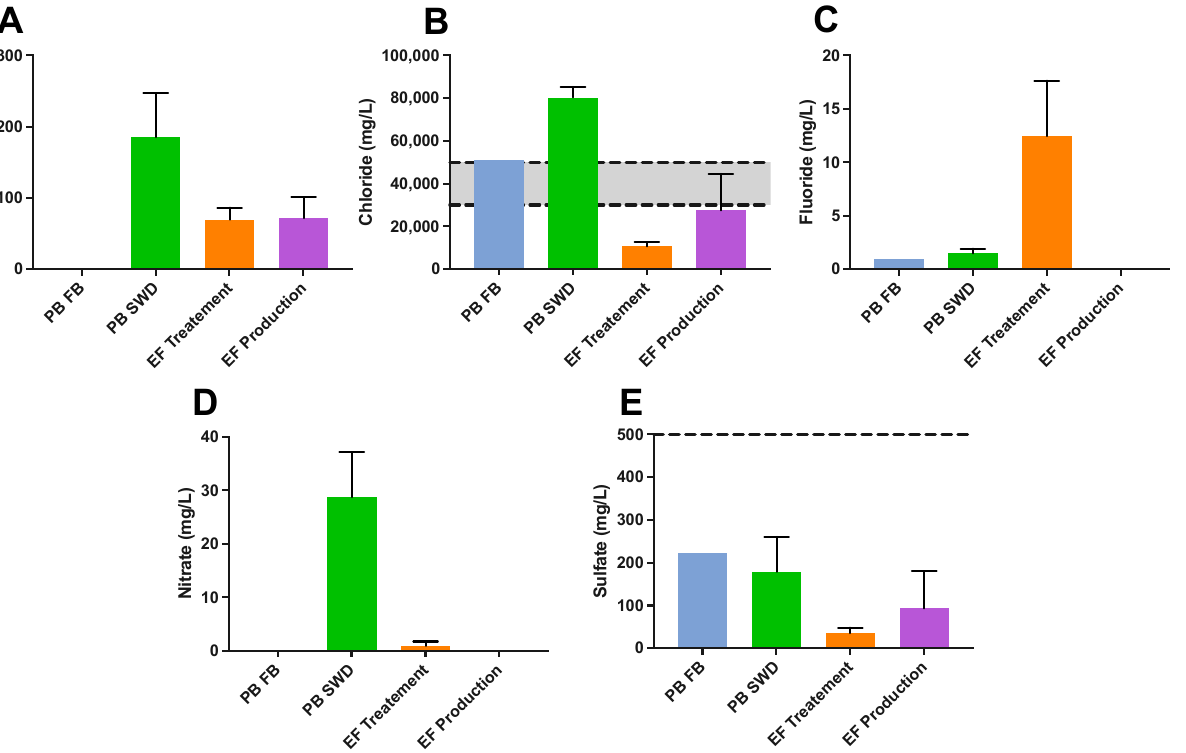
Figure 7. Average anion concentrations found in the PW samples sets for ( A ) bromide, ( B ) chloride, ( C ) fluoride, ( D ) nitrate, and ( E ) sulfate. The reuse limits recommended by Hildenbrand, King, Oetjen, and Liden et al. are represented by black dotted lines. The error bars represent the standard error of the mean [5,27–29].